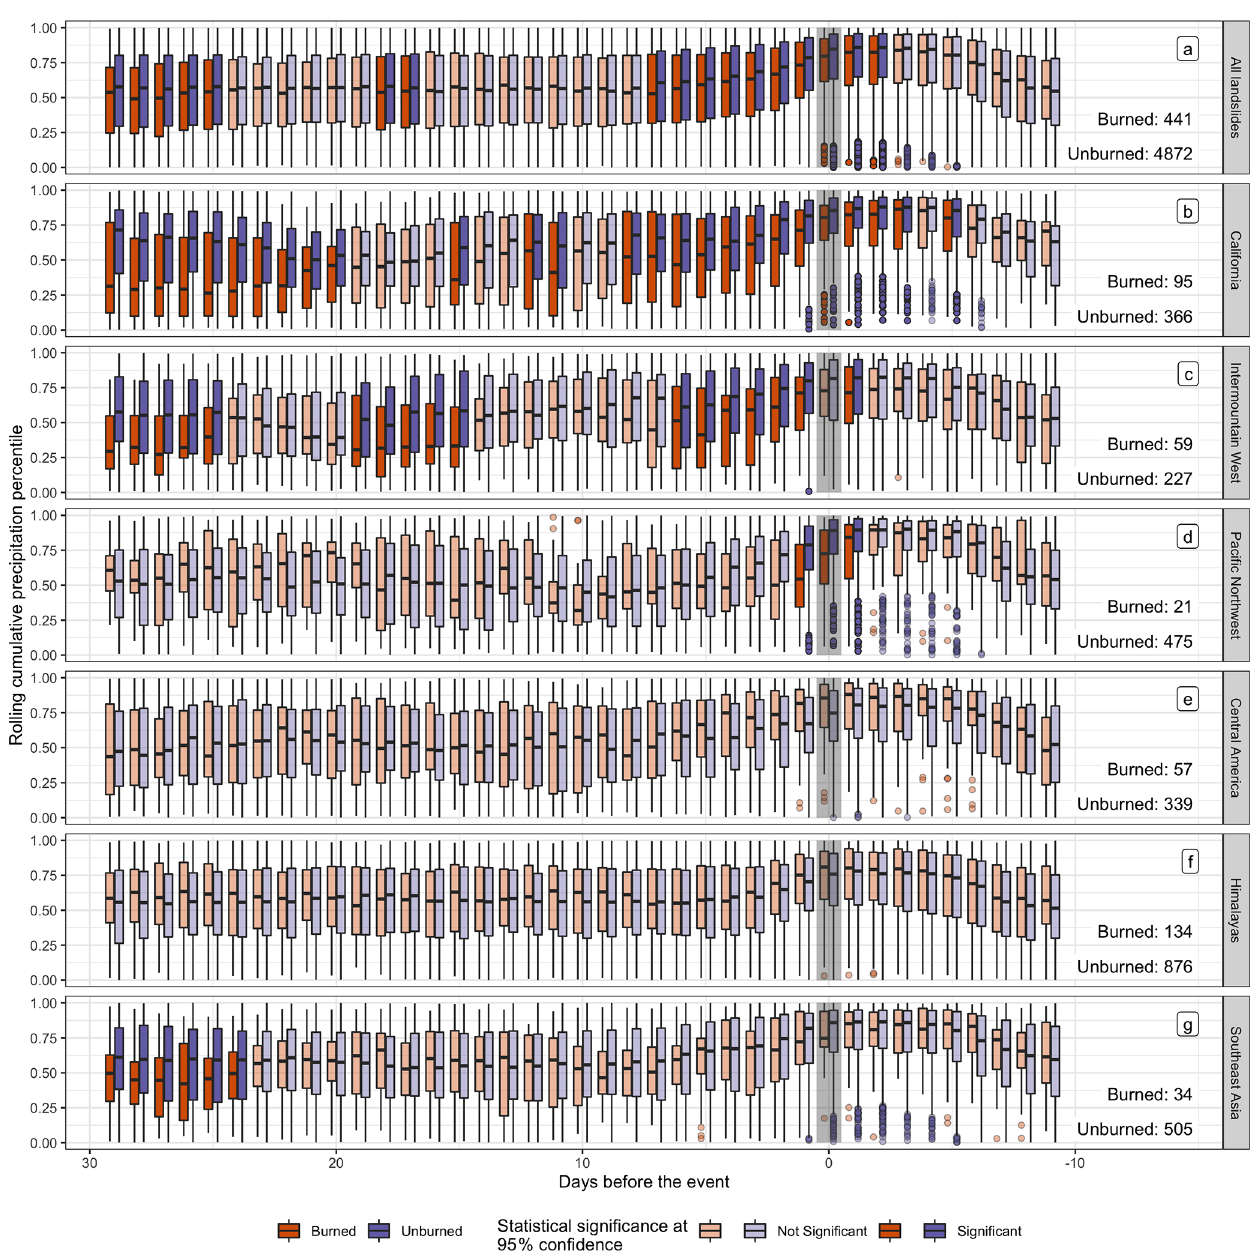
Figure 3. The 7d precipitation percentile in the lead-up to mass movements for all mass movements in panel (a) and for the six individual regions labeled (b) – (g) , whether classified as part of one of the regions or not. The day of the mass movement is indicated with a vertical grey column. Days where a significant difference was found between the burned and unburned groups are indicated in darker colors (Mann– Whitney hypothesis test, p > 0 .